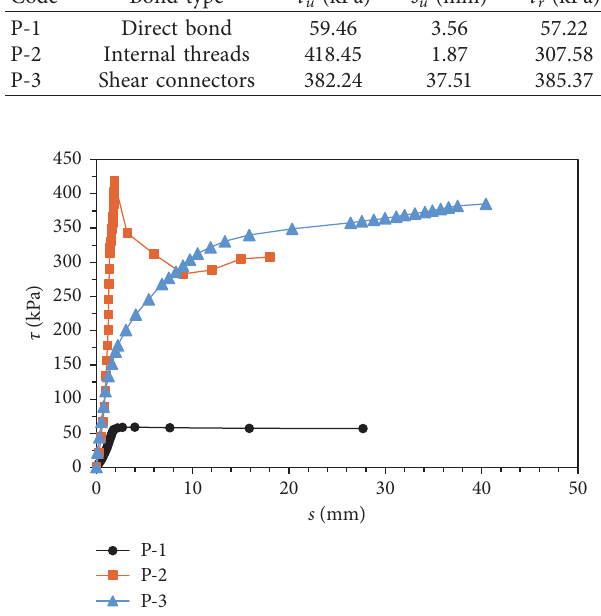
Figure 5: τ − s curves of specimens P-1, P-2, and